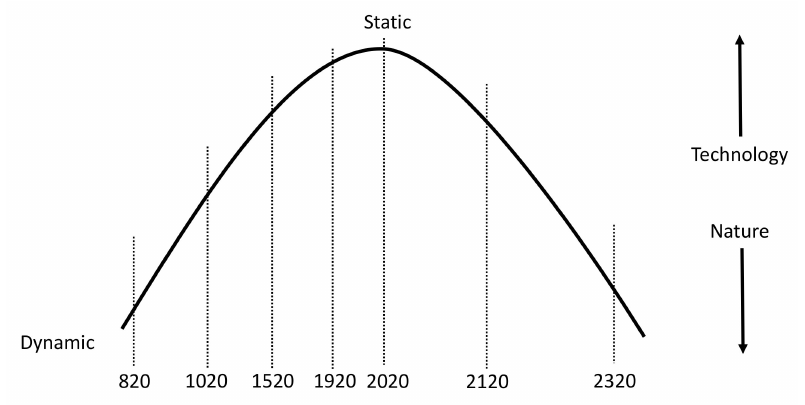
Figure 5. Evolving towards a dynamic natural future.